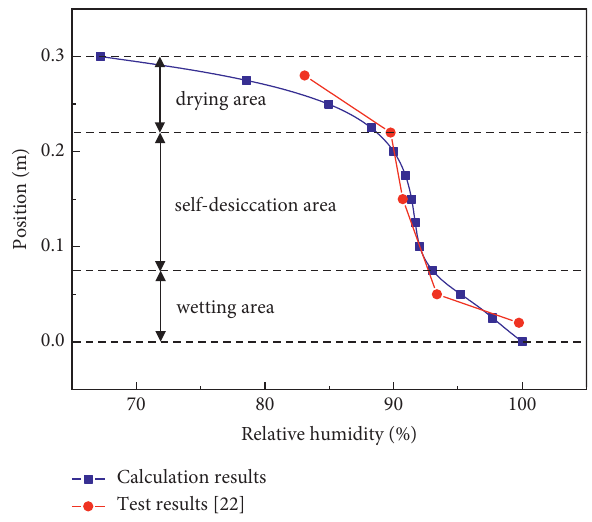
Figure 6: RH distribution along the vertical direction ( t �